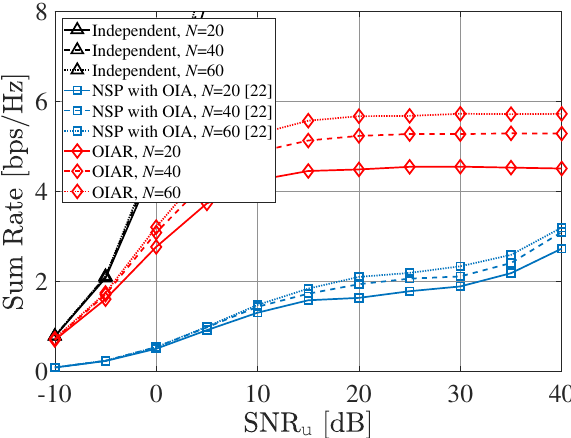
Figure 8. Sum-rate of communication system according to SNR u with different N